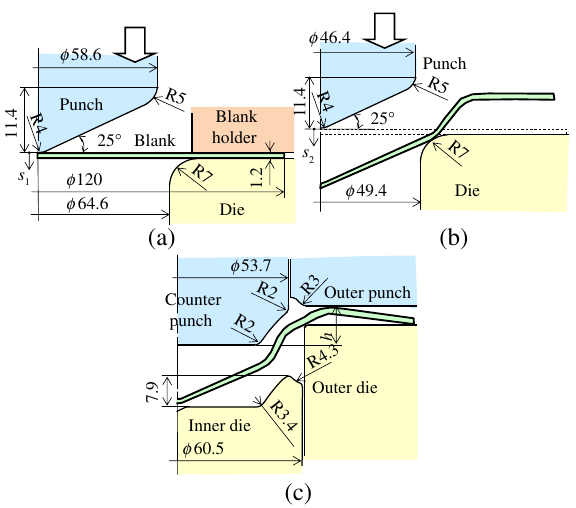
Figure 3. Stamping conditions in (a) 1st stage, (b) 2nd stage and (c) 3rd stage.